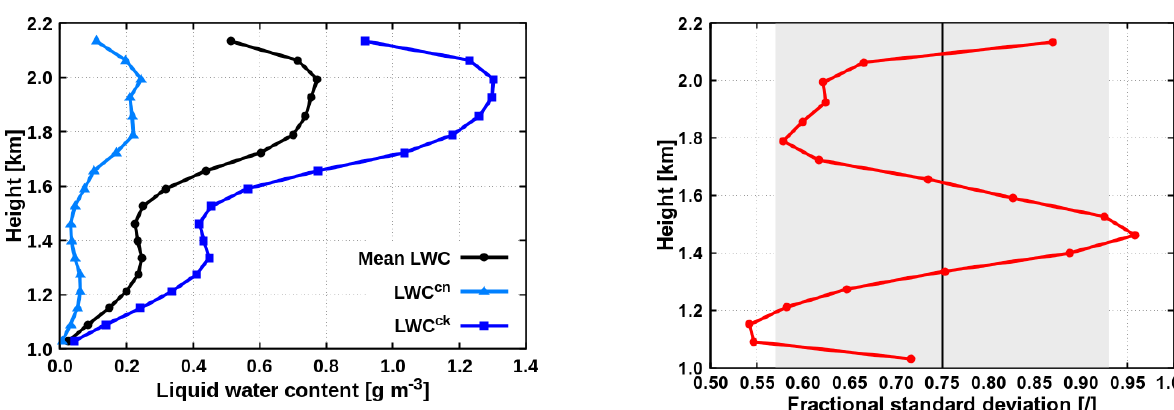
Figure 10. The actual FSD of the shallow cumulus. The grey- shaded area represents the uncertainty of global FSD estimate, cen- tered around its mean value (black line).